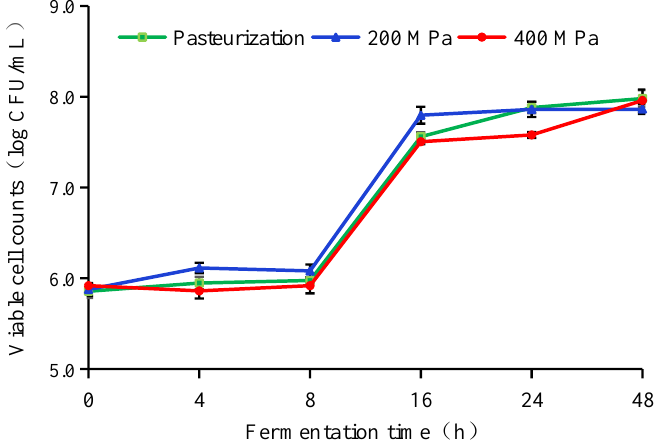
Figure 3. Variations of viable cell number of different treated apple juices during fermentation. HHP treatments (200 or 400 MPa, 10 min); pasteurization (85 °C, 15 min). Experiments were performed in triplicate; vertical bars indicate ± SD ( p < 0.05).